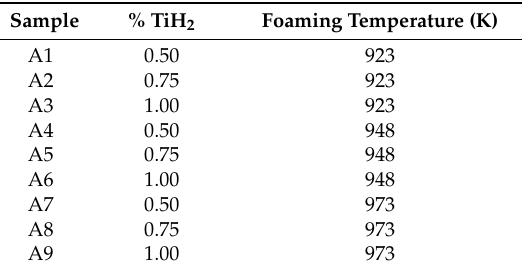
Table 4. Values selected for the preparation of A-242 aluminium alloy foams (foaming time is constant for 30